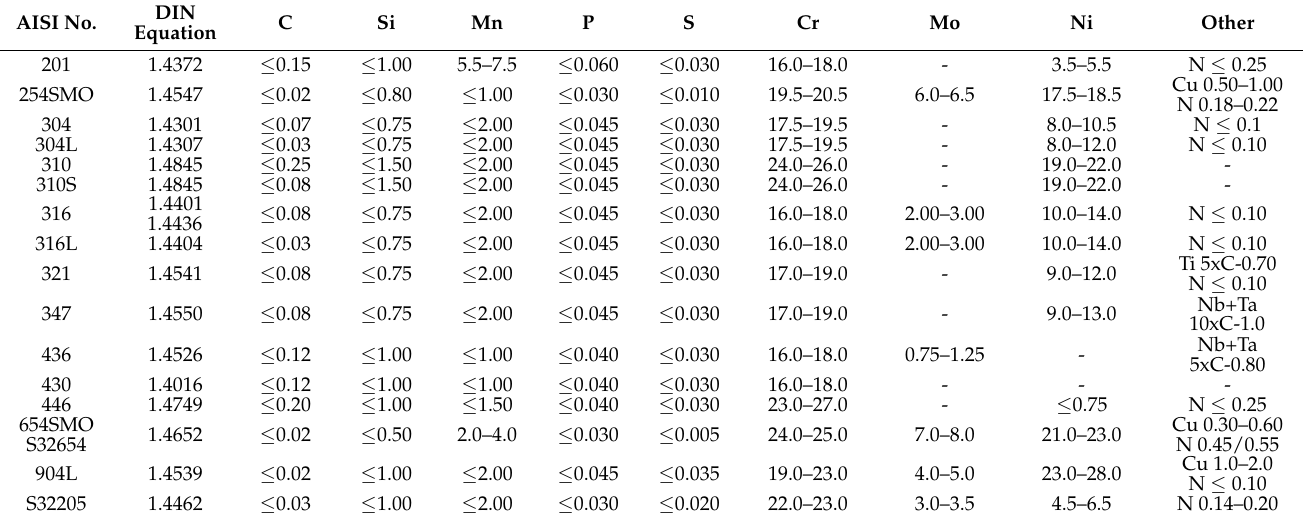
Table 2. Chemical composition of tested steels according to